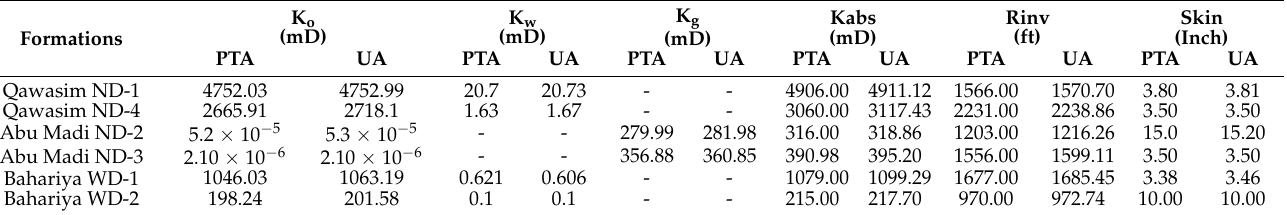
Table 6. A comparison of Monte Carlo uncertainty analysis (UA) results with the corresponding parameters from the conventional pressure transient analysis (PTA) for all well